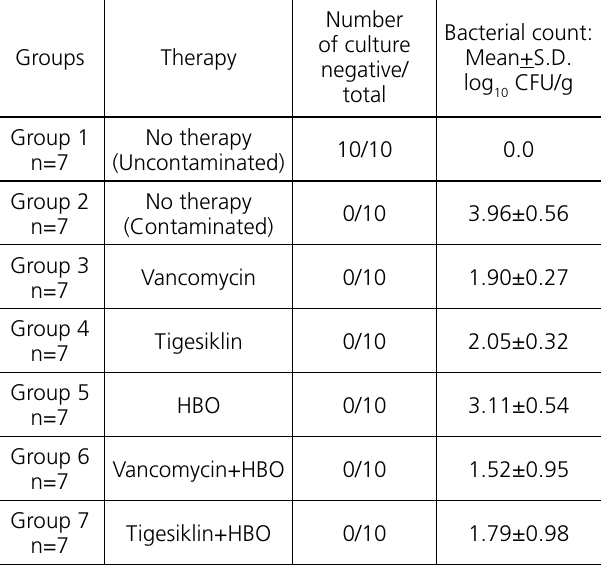
Table 1. The results of experimental rat mediastinitis after treatment.